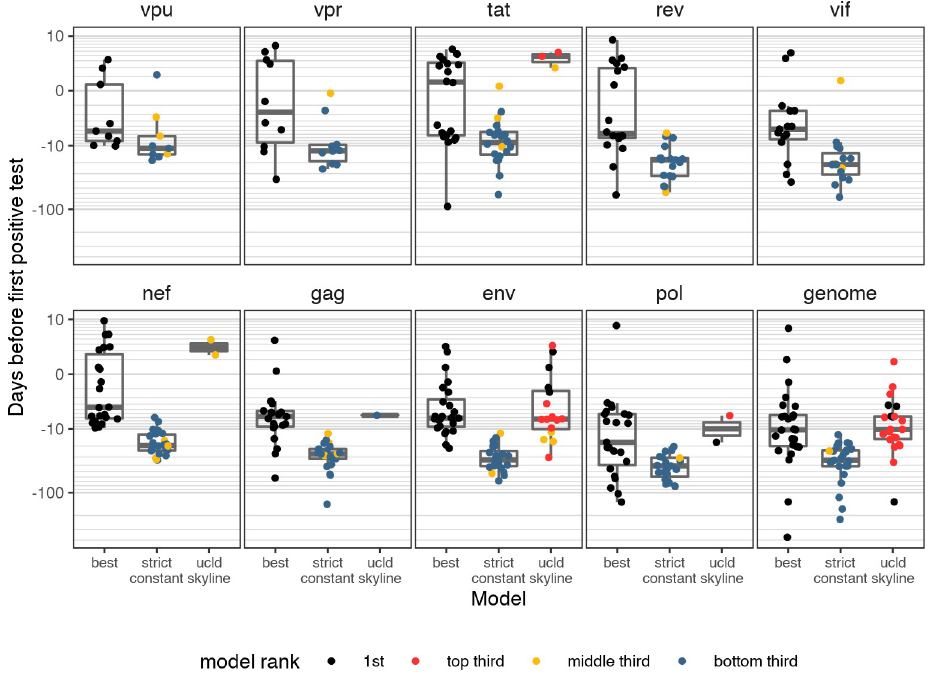
Fig 6. Estimates of the date of infection for the best-fitting model, compared to the UCLD-skyline and strict- constant models. Points are colored according to the relative rank of that model out of all models fitted for that participant and gene. Not all participants had a UCLD-skyline or strict-constant model